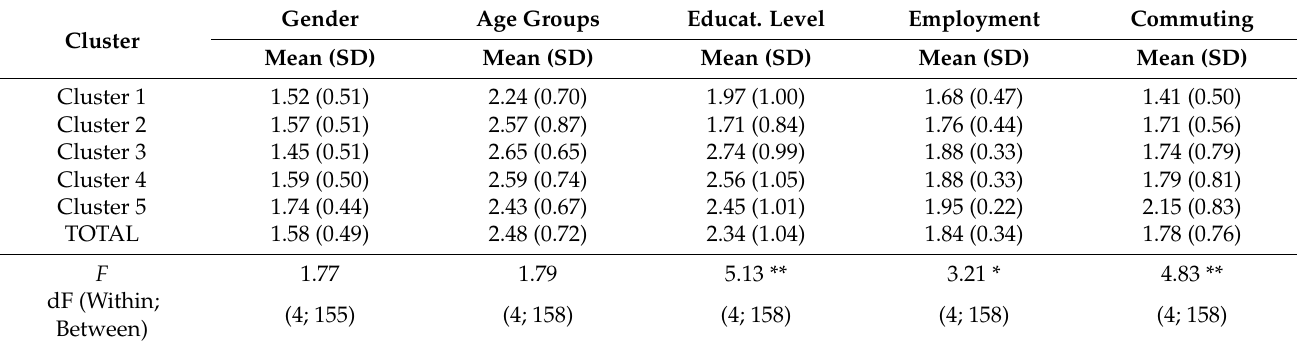
Table 5. Clusters and respondents’ characteristics